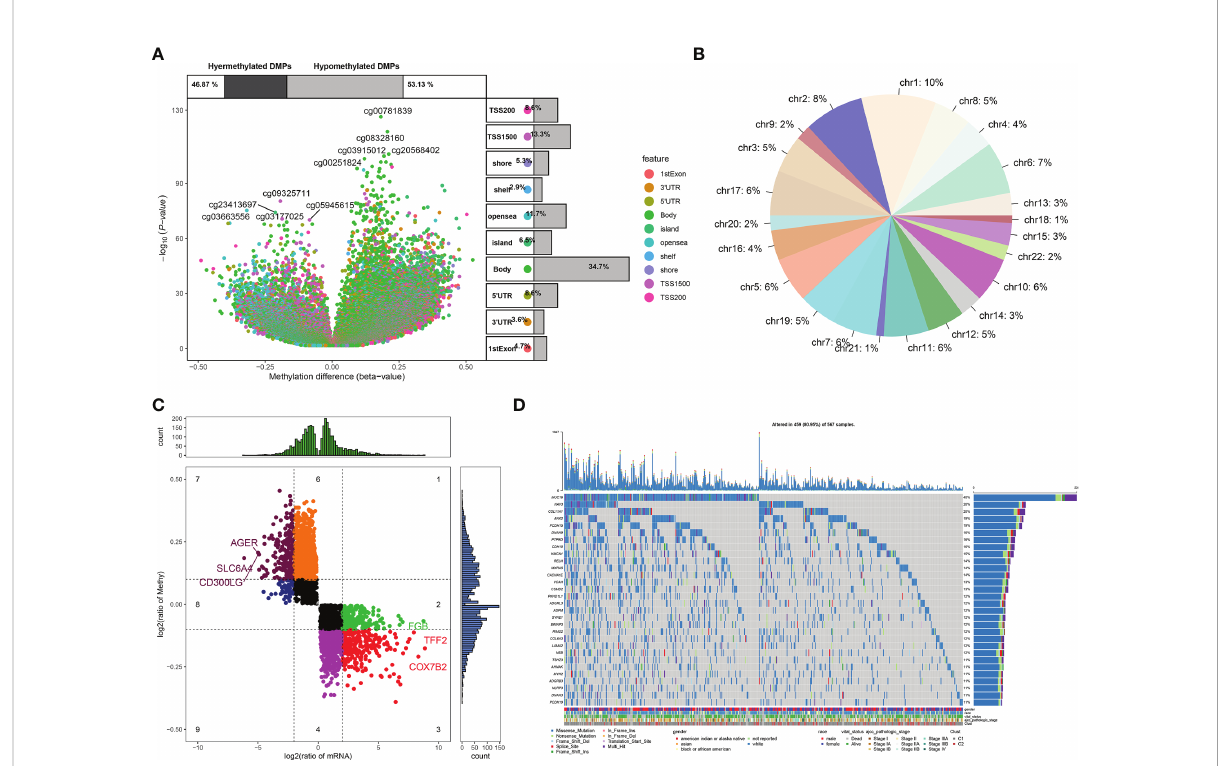
FIGURE 4 DNA methylation and genetic mutation of module genes across LUAD. (A) Differentially methylated sites between LUAD and normal lung tissues. (B) Distribution of differentially methylated sites on the chromosomes. (C) DEGs that were potentially in fl uenced by DNA methylation. (D) Landscape of the top 30 mutated module genes across LUAD. LUAD, lung adenocarcinoma; DEGs, differentially expressed